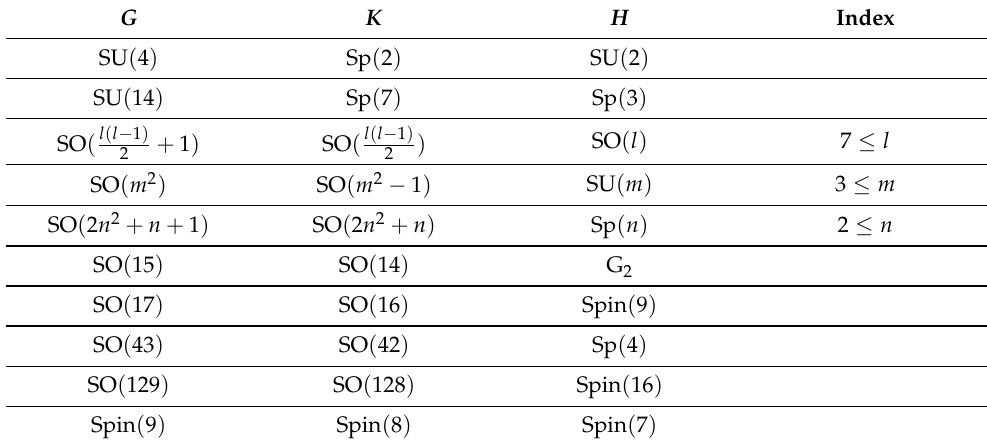
Table 1. No non-naturally reductive left-invariant B -metrics, such as Equation (1) on G . G K